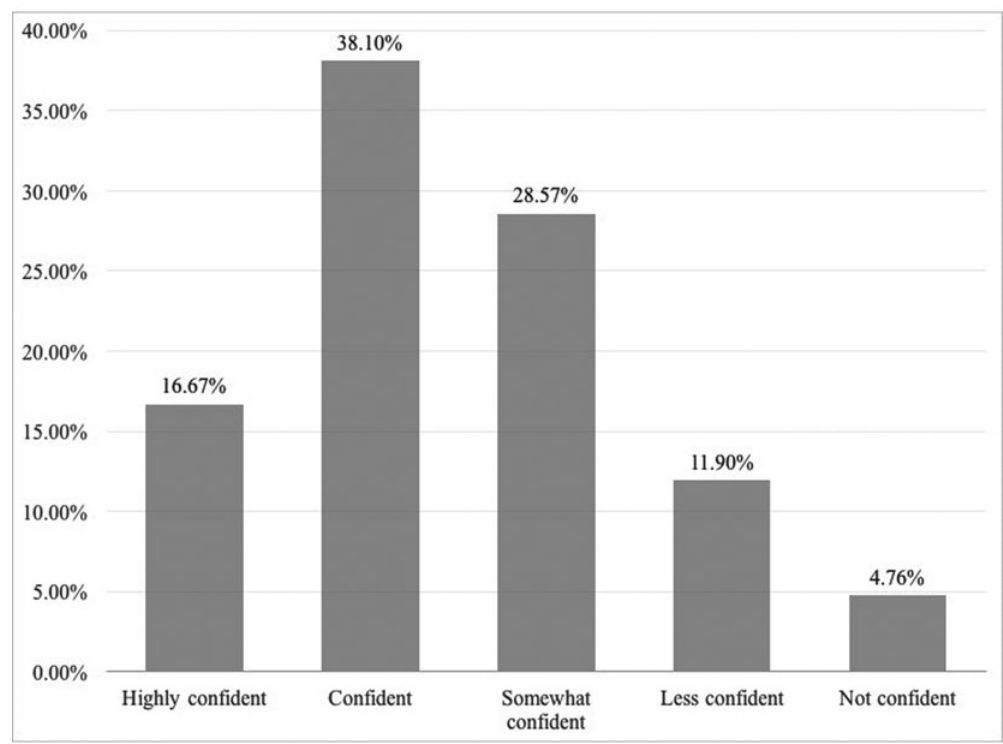
Confidence in issues that need to be solved in local and national